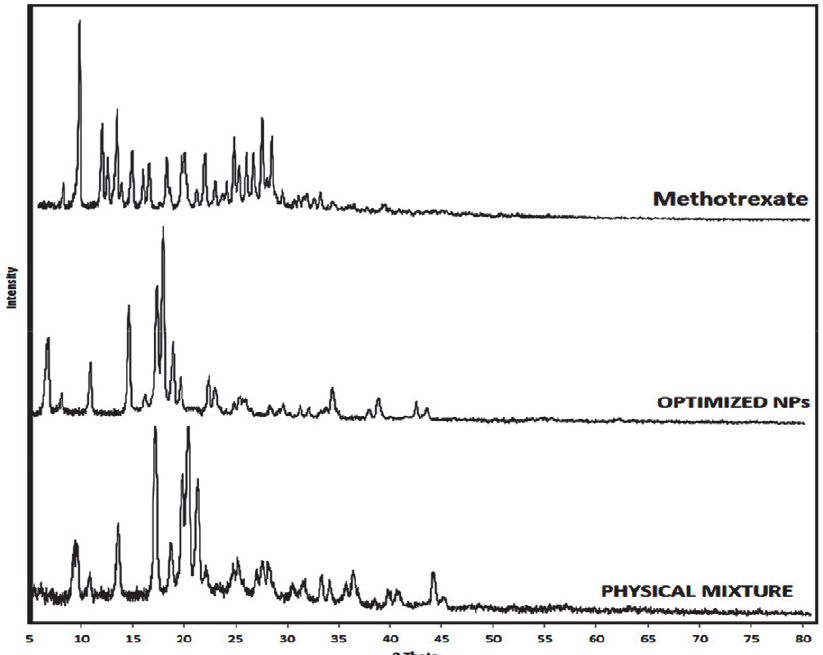
Figure 7. PXRD Spectra of A) Pure MTX B) Optimized MTX-NS C) Physical mixture